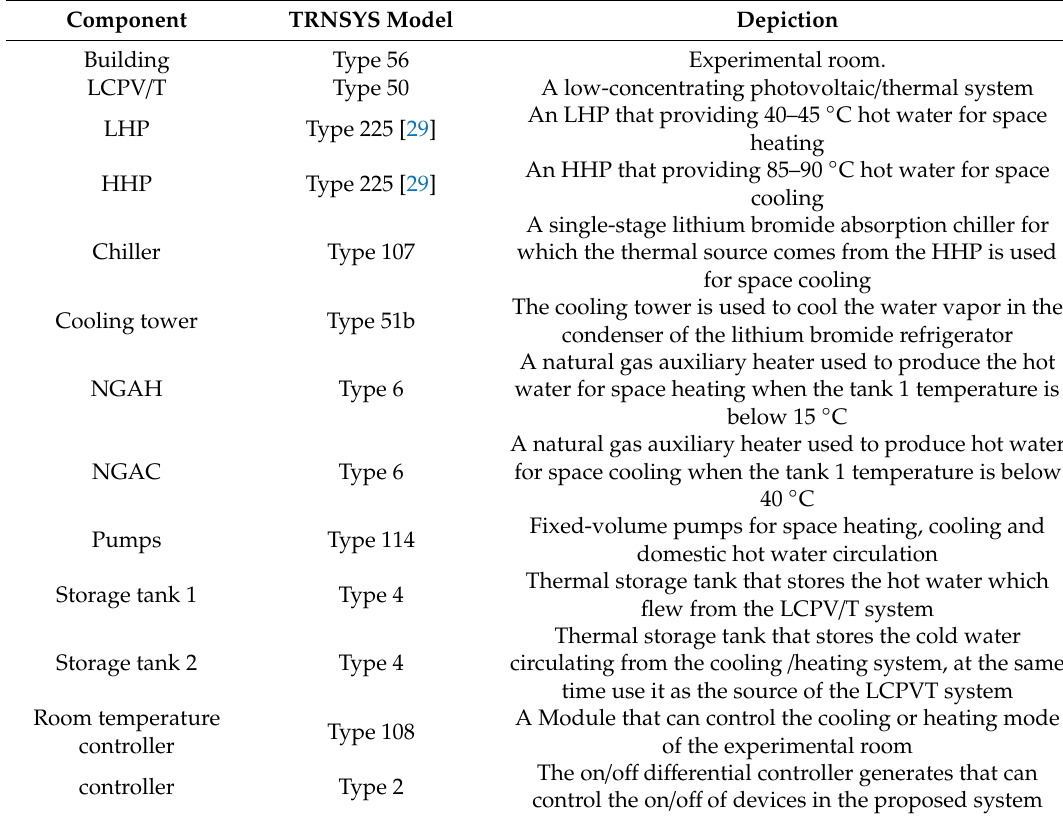
Table 1. Depiction of main